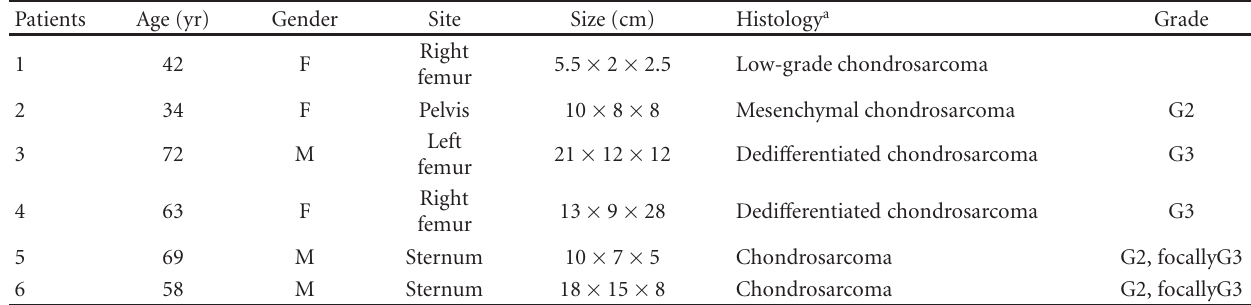
Figure 1: uPAR protein is expressed in chondrosarcoma tissues. Immunohistochemistry was performed on frozen sections with the streptavidin-biotin-peroxidase method using 2 μ g/mL R4 anti-uPAR mAb. Sections were counterstained with haematoxylin. Original magnifications: x400. Table 1: Histopathological findings of enrolled chondrosarcoma patients.